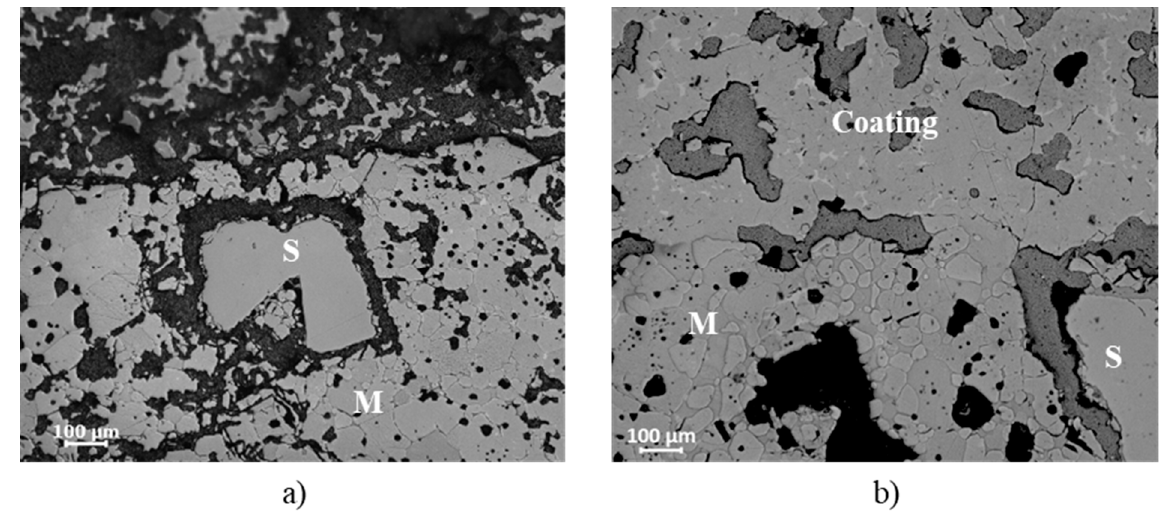
Figure 7. Microstructure of the clinker–brick interface of composition ( a ) A-1 ( b ) A-3 after the sandwich coating test (M = magnesia, S = fused spinel)—100× magnification.